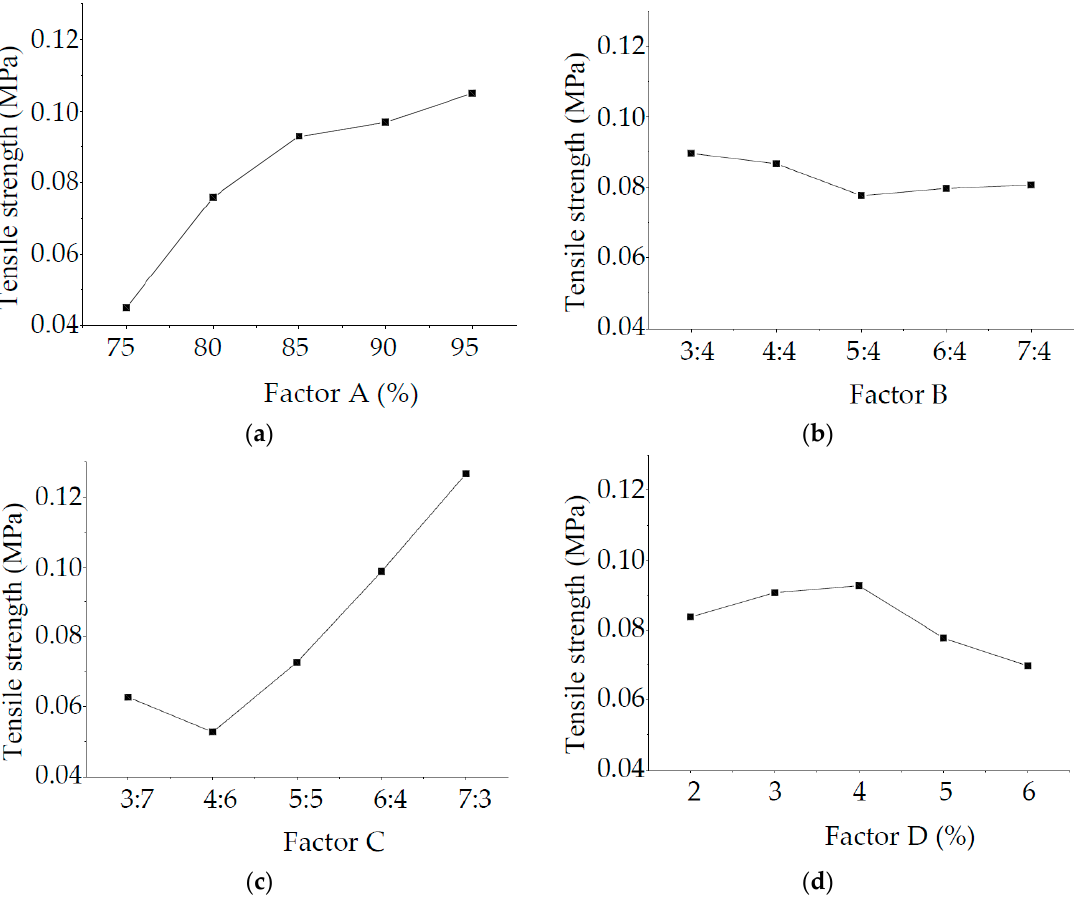
Figure 7. Intuitive analysis chart of tensile strength influencing factor: ( a ) Factor A; ( b ) Factor B; ( c ) Factor C; ( d ) Factor D.